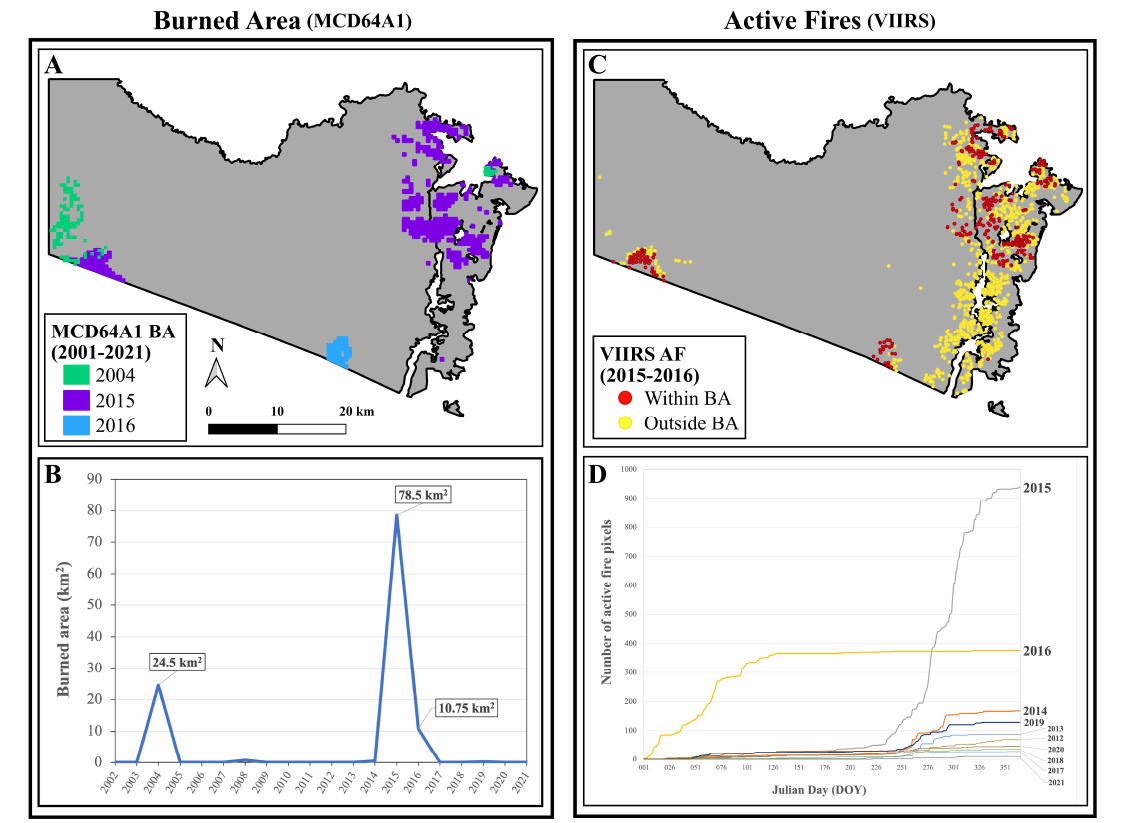
Figure 4. MCD64A1 (left): location ( A ) and annual estimates ( B ) of detected burned area (BA) within KNP between 2002–2021. VIIRS (right): active fire detections within and outside the perimeters of detected BA in KNP between 2015–2016 ( C ) and cumulative active fire detections across days of the year (DOY) between 2012–2021 within KNP ( D